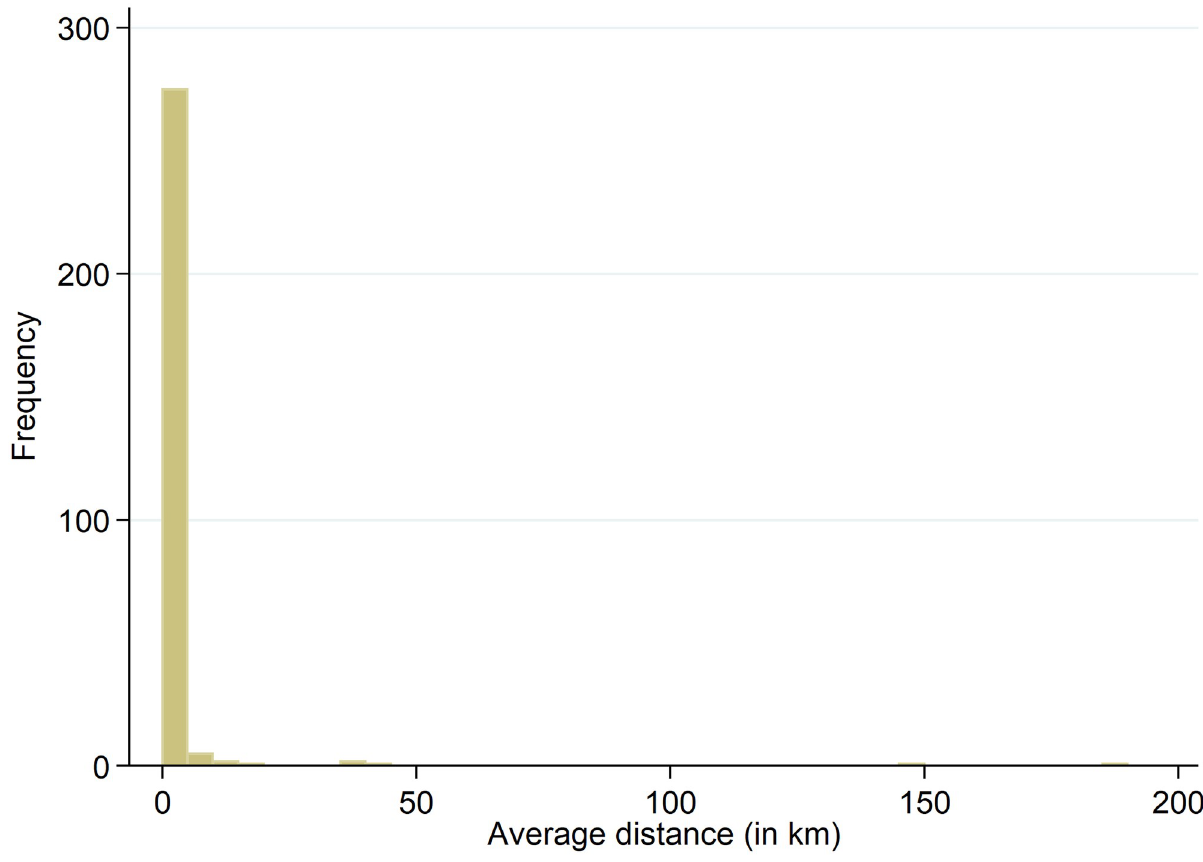
Fig 10. Average distance per municipality for network domain not set